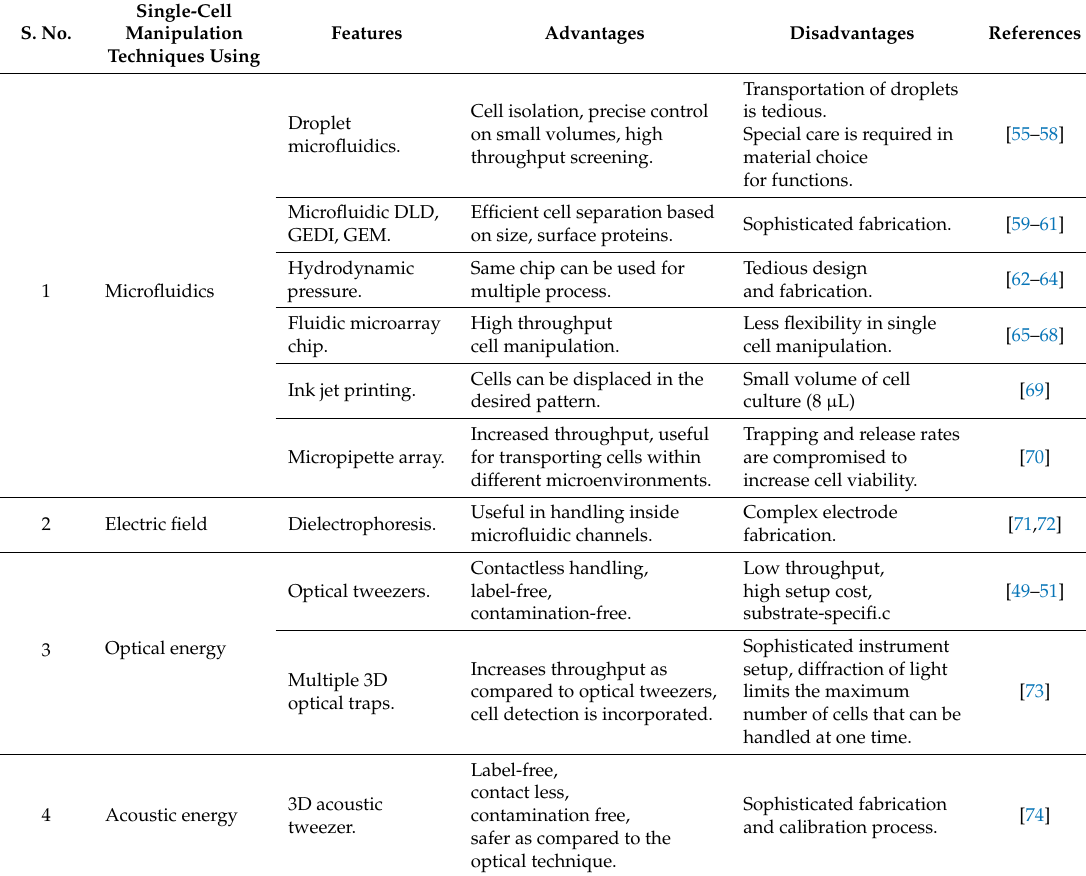
Table 1. Single-cell manipulation